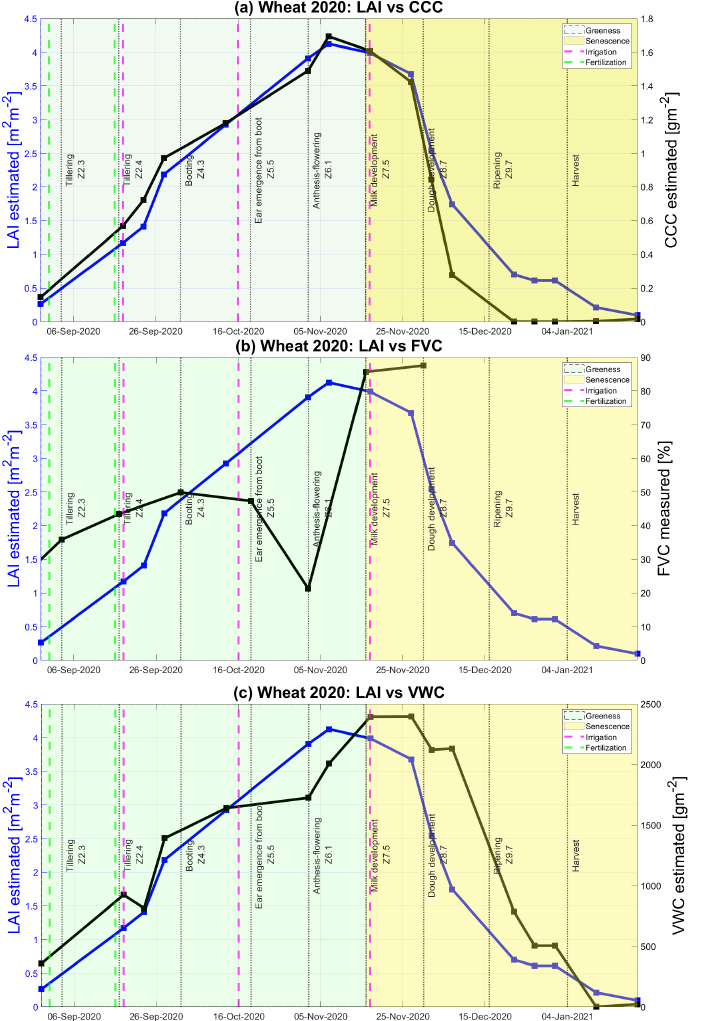
Figure 12. Temporal evolution of wheat cropland over the three paddocks at the BVCR study sites described by LAI, CCC and VWC mean values of nine ESUs within the crop limits and the associated SD, which is plotted as vertical bars. ( a ) LAI vs. CCC temporal estimates; ( b ) LAI temporal estimates vs. FVC in-situ measured values; ( c ) LAI vs. VWC temporal